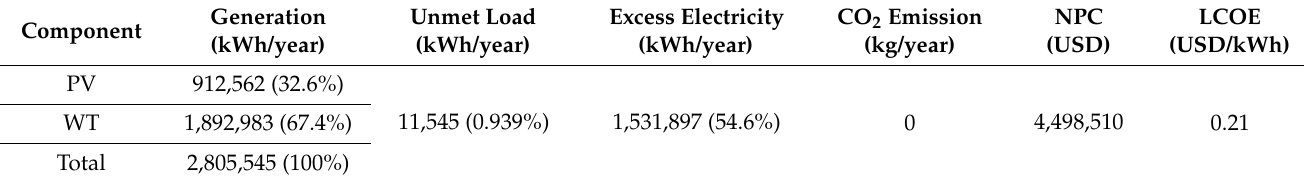
Table 9. Simulation result of topology_B under